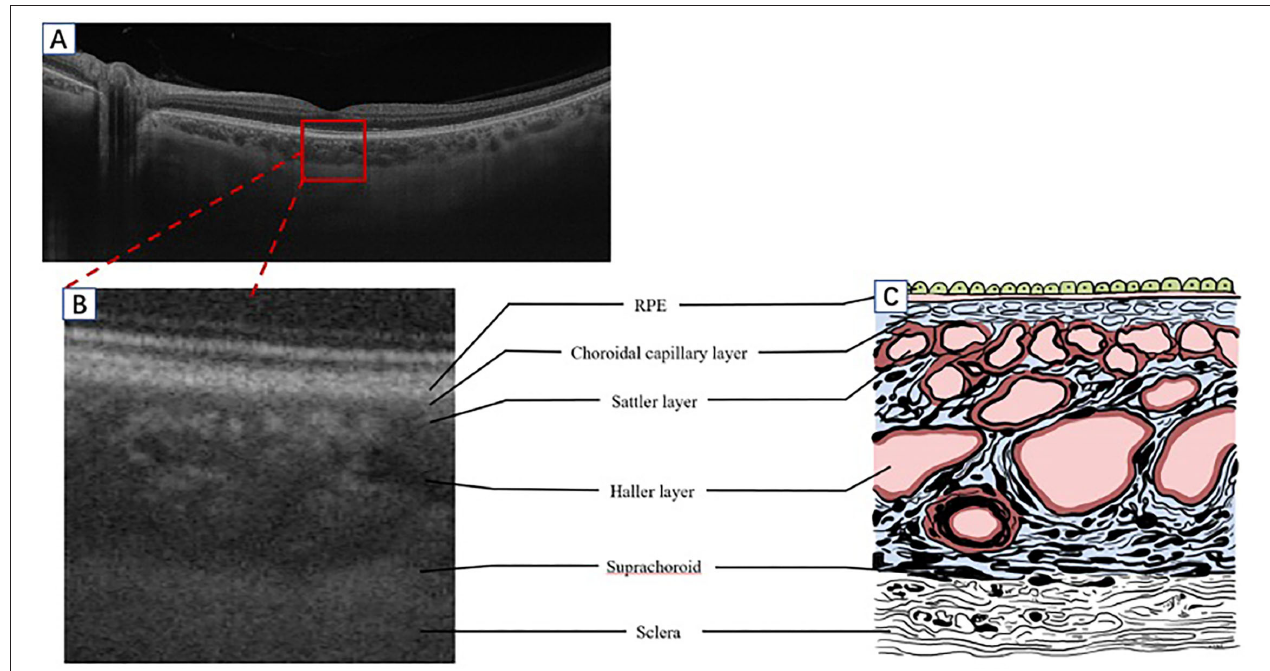
FIGURE 1 | A schematic diagram of the human choroid and the corresponding OCT signal. (A) Segmentation of the retina and choroid as shown by SS-OCT B-scan (Plex Elite 9000, Carl Zeiss Meditec, Inc., Oberkochen, Germany). (B) A partially enlarged image of the OCT B-scan signal corresponding with a schematic diagram (C) . OCT, optical coherence tomography; SS-OCT, swept-source OCT; RPE, retinal pigment